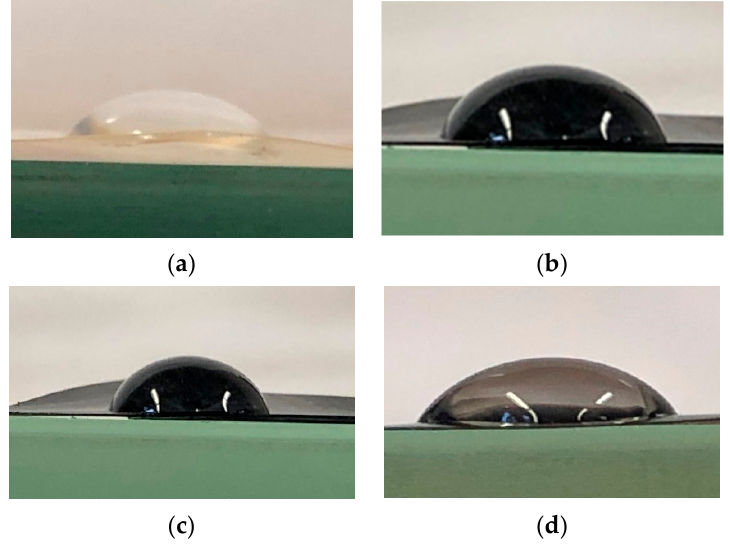
Figure 10. Contact angle of water in the presence of ( a ) PVA film; ( b ) PVA_CNT_COOH; ( c ) PVA_GO_CNT_COOH; ( d ) PVA_GO. Table 2. Summary of Contact Angles for Pristine PVA and fabricated